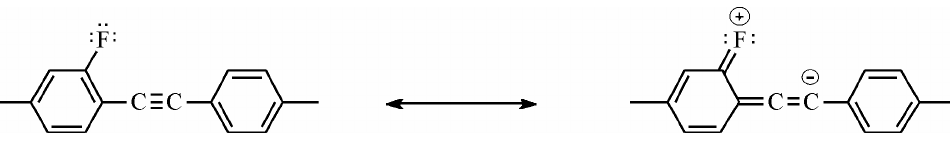
Figure 7. A resonance structure in fluorinated tolane, which flattens the molecule.